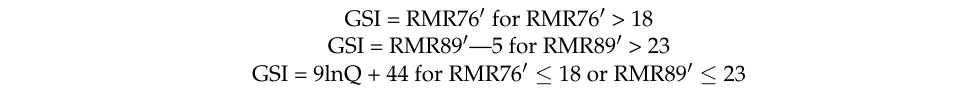
Table 2. Equivalencies between GSI, RMR and Q proposed in [3].